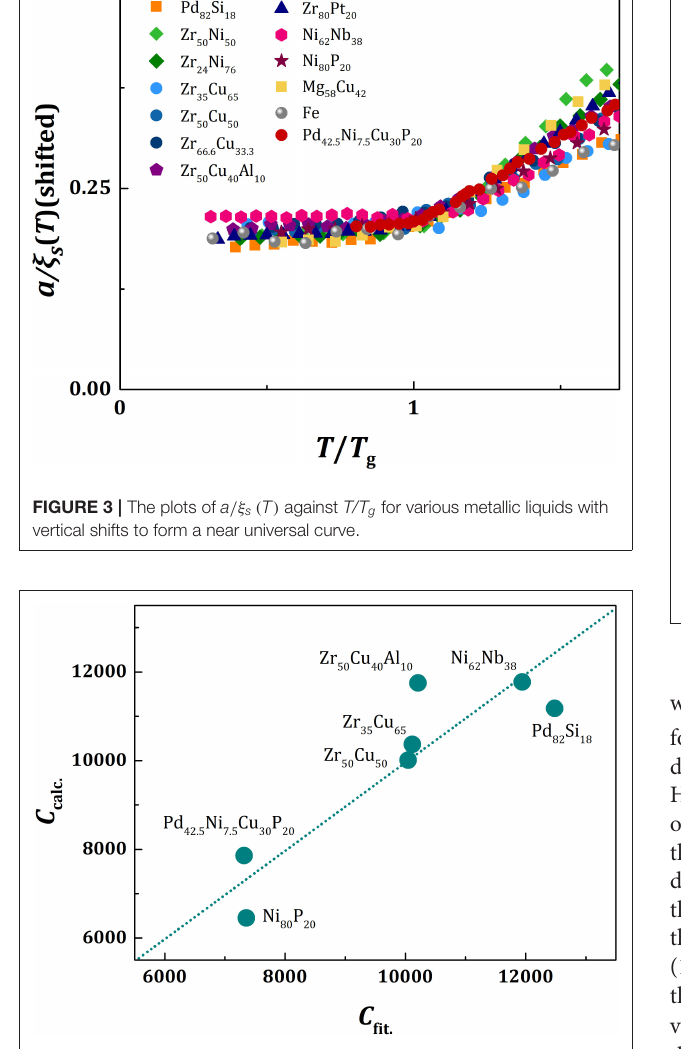
FIGURE 4 | The value of C given by Equation (17), C calc , plotted against the value of C fit by Equation (11), C fit , for various liquids. The dotted line is a linear fit, which is virtually identical to the line for C calc = C fit .